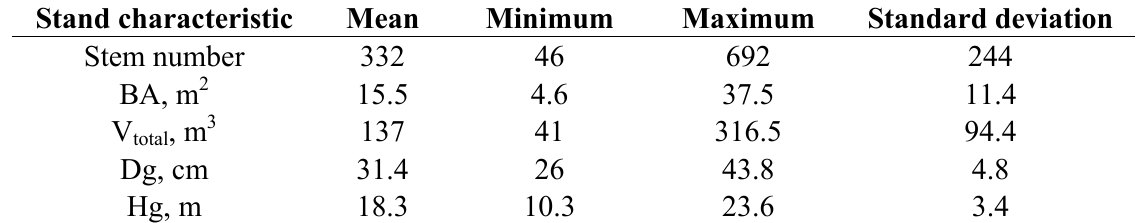
Table 1. Statistics for stem number, basal area (BA), total volume (V (Dg) and mean height (Hg) of the stands ( n = 15) according to the logging machine data. Stand